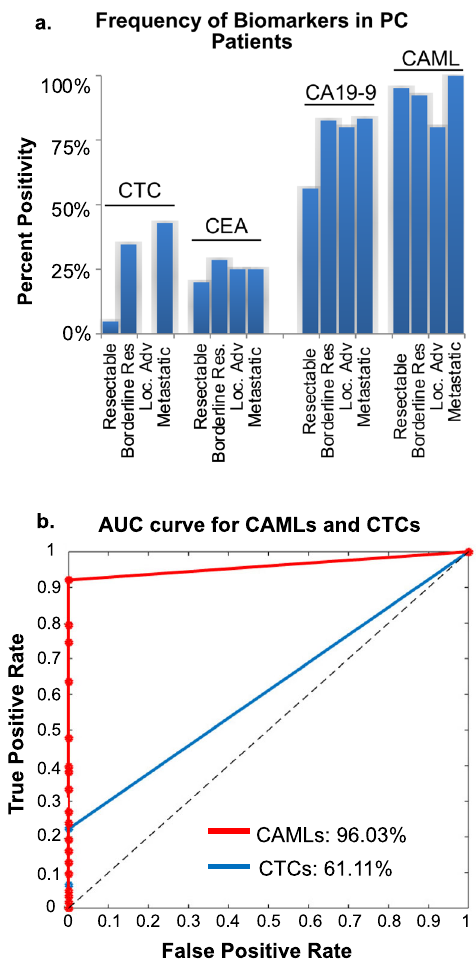
Fig. 2 Sensitivity and Speci fi city of CTCs and CAMLs in Pancreatic cancer patients referred for resection. a Frequency of CTCs (>1 cell/ sample), CEA (>5 ng/mL), CA19-9 (>37 µg/mL), and CAMLs (>1 cell/ sample) as they relate to resectability. b ROC curve showing the speci fi city/sensitivity of CAMLs (red) and CTCs (blue) in comparison with 40 healthy